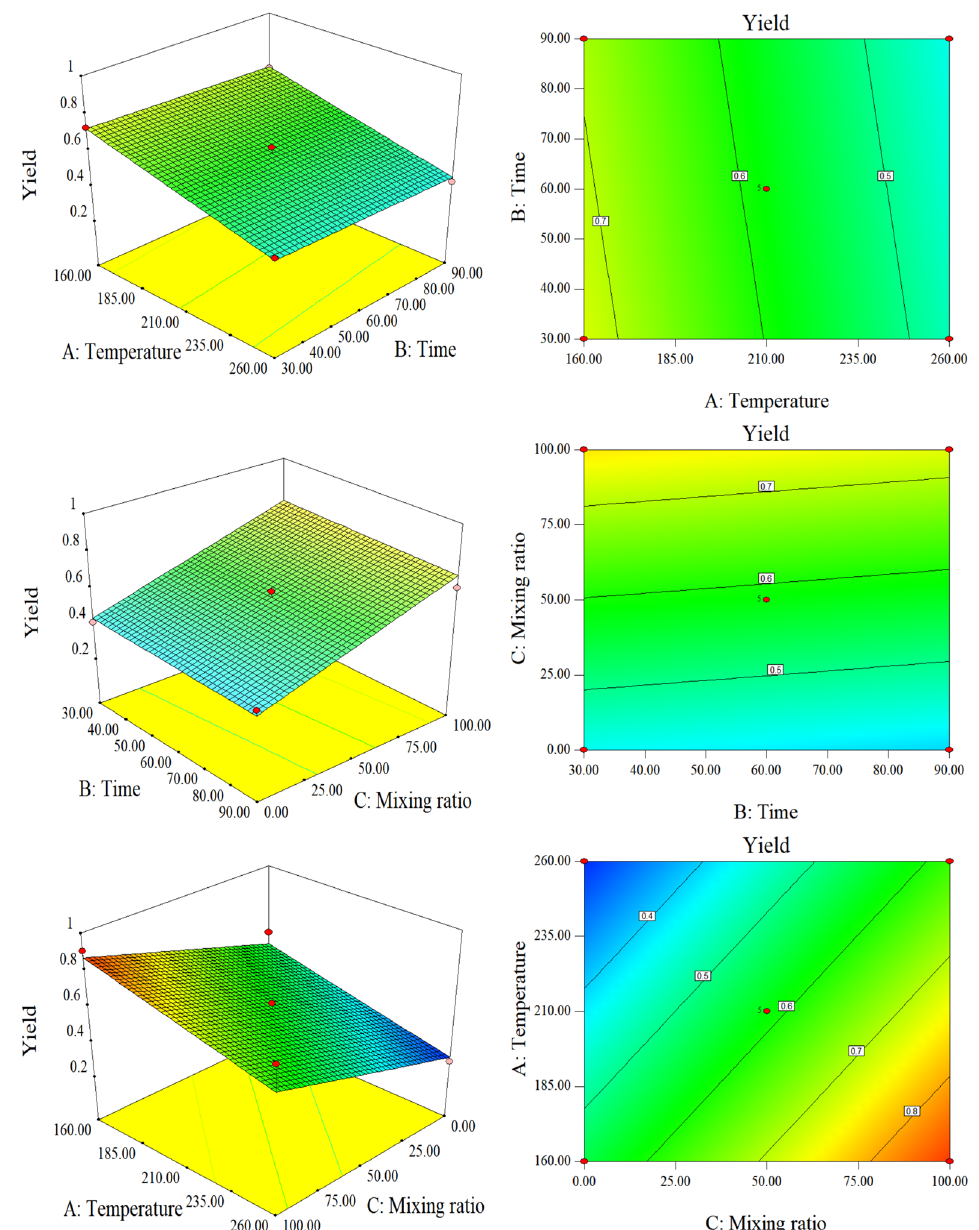
Figure 3. Response surface plots and contour plots of the yield.